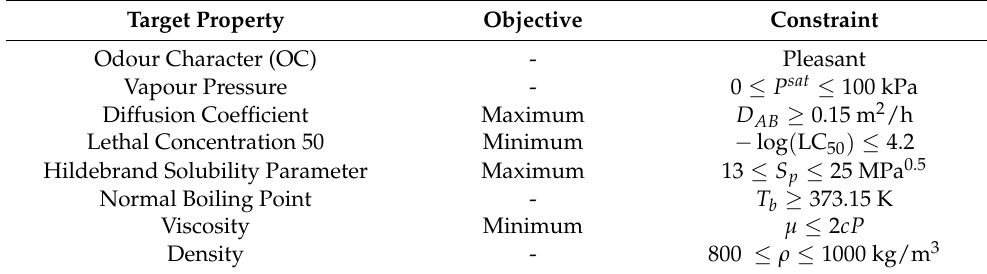
Table 6. Target Properties and their